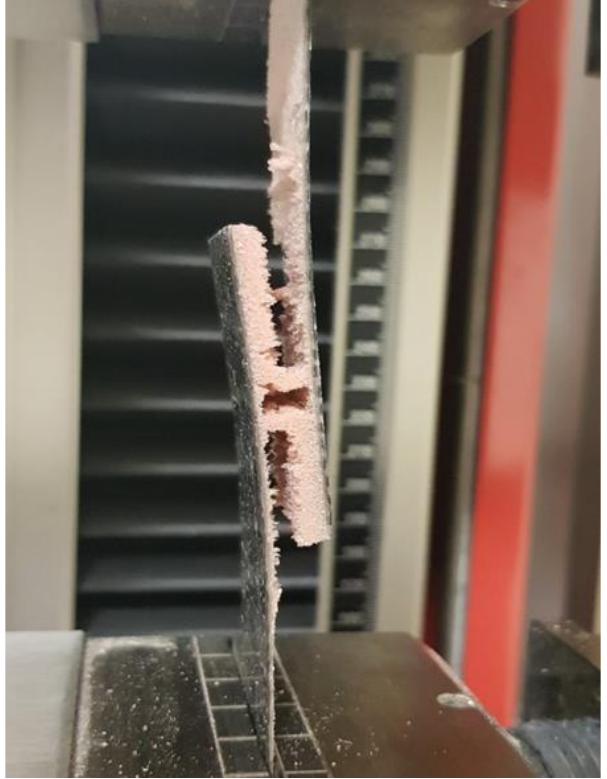
Figure 17. Test sample destroyed in the grip of a Herex core testing machine.